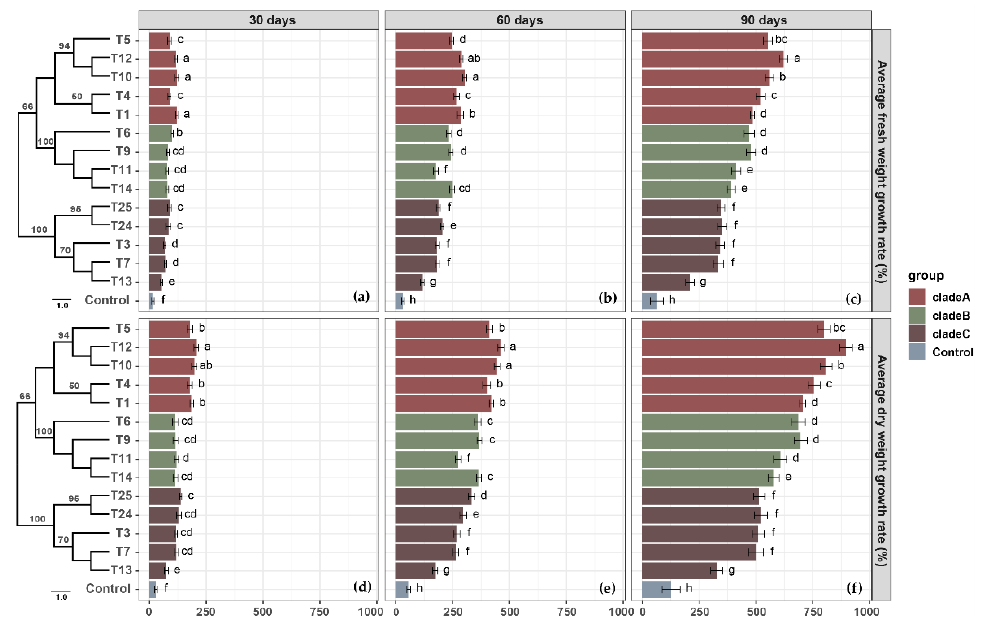
Figure 5. Comparison of the average fresh and dry weight growth rates of 14 fungi on the 30th, 60th, and 90th days of symbiosis. ( a ) The average fresh weight growth rate on day 30 after co-culture. ( b ) The average fresh weight growth rate on day 60 after co-culture. ( c ) The average fresh weight growth rate on day 90 after co-culture. ( d ) The average dry weight growth rate on day 30 after co-culture. ( e ) The average dry weight growth rate on day 60 after co-culture. ( f ) The average dry weight growth rate on day 90 after co-culture. Strains with different lowercase letters are significantly different ( p < 0.05) based on the LSD test.